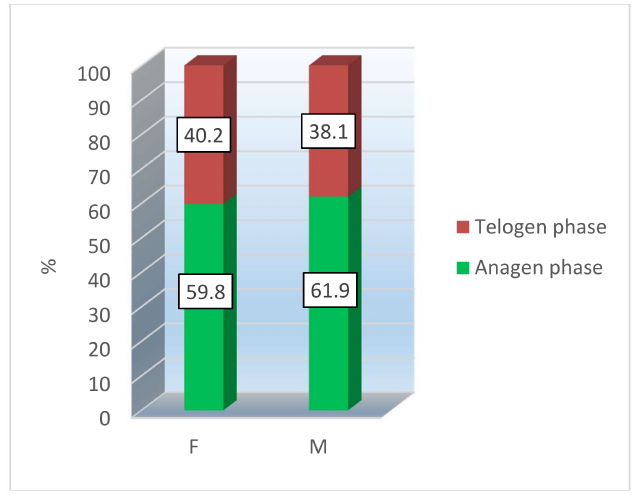
Figure 5. Mean basal values of the percentage of hair in anagen/telogen phase as a function of